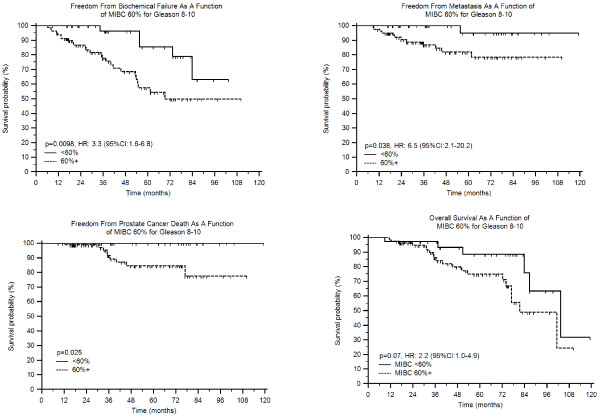
 Failure patterns for patient cohort based on Gleason 8–10 stratified by having less than or equal to 60% MIBC vs. greater than 60% MIBC. (a) FFBF. (b) FFM. (c) CSS (d) OS.